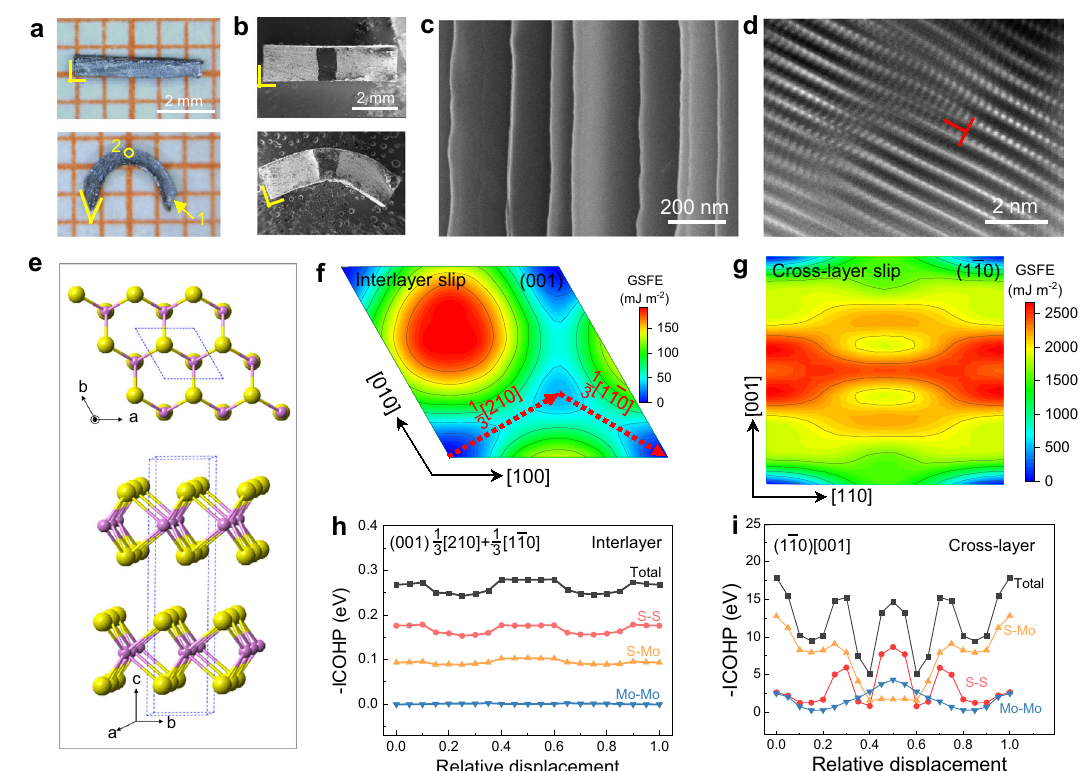
Fig. 4 | Plasticity mechanism of MoS 2 . a Optical images of a bar-shaped MoS 2 crystalbefore and after bending. b Scanning electron microscopy (SEM) images of anAgbar before and afterbending. Black ink ismarked on sample ’ s topsurface to help to fi x the position. c SEM image of area 1 in a . d , Inverse Fourier transform of the dark- fi eld scanning transmission electron microscopy (IFT-DF-STEM) image of area 2 in a . e Crystal structure of 2H-MoS 2 . f Generalized stacking fault energy